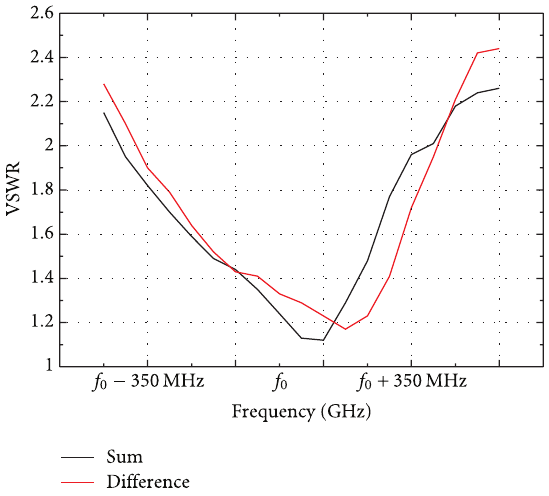
Figure 9: The VSWR of sum and di ff erence port of the monopulse circular-polarized DCWS antenna array.